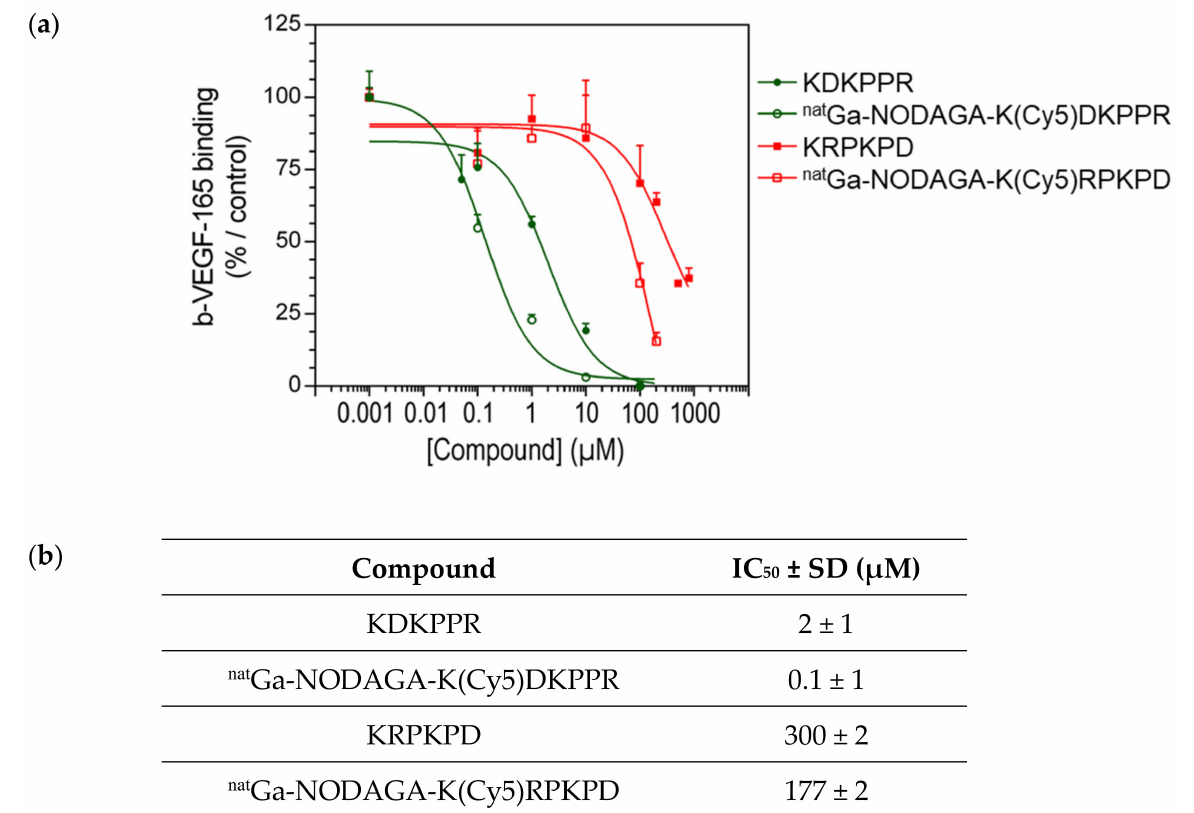
Figure 5. ( a ) Binding to the recombinant NRP-1 protein: competitive binding assay. Binding of b-VEGF-165 to NRP-1 was evaluated in the presence of the increasing concentration of nat Ga-NODAGA-K(Cy5)DKPPR (empty green circle) or nat Ga-NODAGA-K(Cy5)RPKPD (empty red square) compared with KDKPPR (circle filled with green) or KRPKPD (circle filled with red). Data points show the mean ± SD ( µ M), and the lines represent the one-site fit log-IC 50 nonlinear analysis regression curve. ( b ) Binding to the recombinant NRP-1 protein: competitive binding assay. The IC 50 were calculated using the one-site fit log-IC 50 nonlinear analysis regression curve.